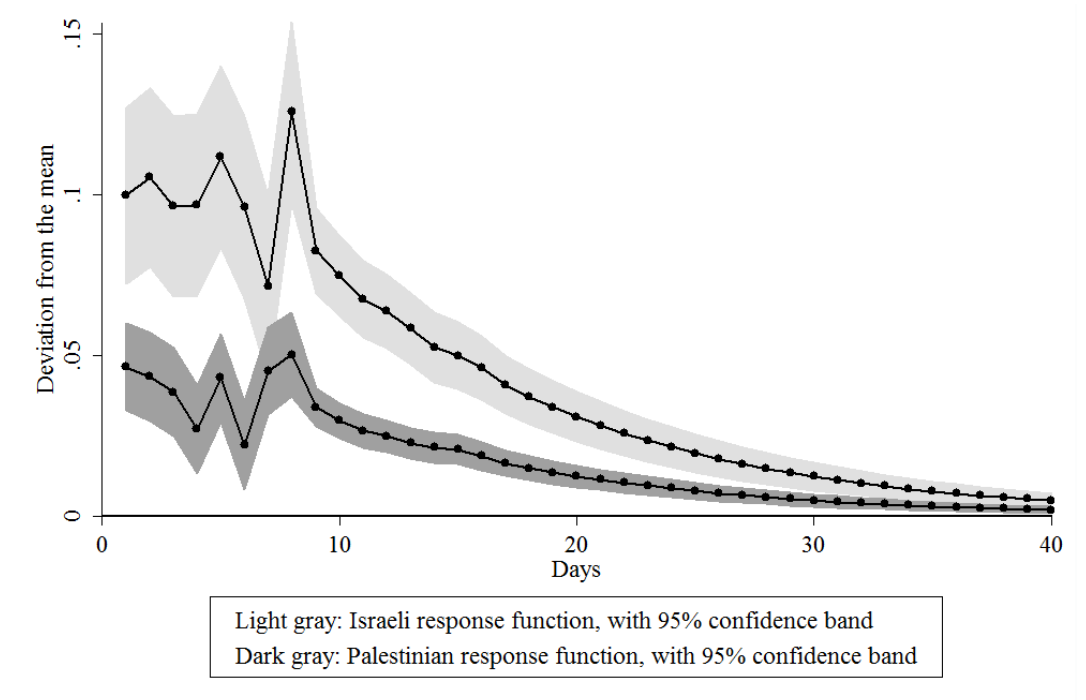
Figure 2: Impulse Response Functions for Israeli-Palestinian Interactions, 1979-2009. Legend: Israeli and Palestinian response functions reflect a statistically significant pattern of tit- for-tat interaction over the past generation.